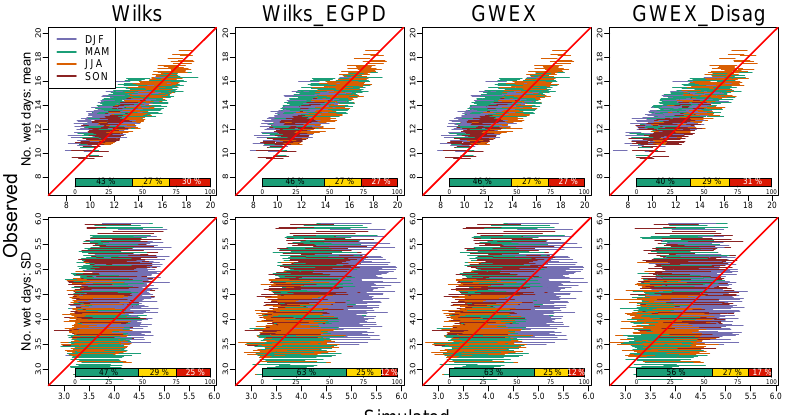
Figure 7. At-site number of wet days for all sites and months: inter-annual mean and standard deviation (SD). The 90% probability limits are shown for the different seasons. Overall performance is represented by the indicated percentages of good, fair, and poor performance for all sites and months (105 × 12 = 1260